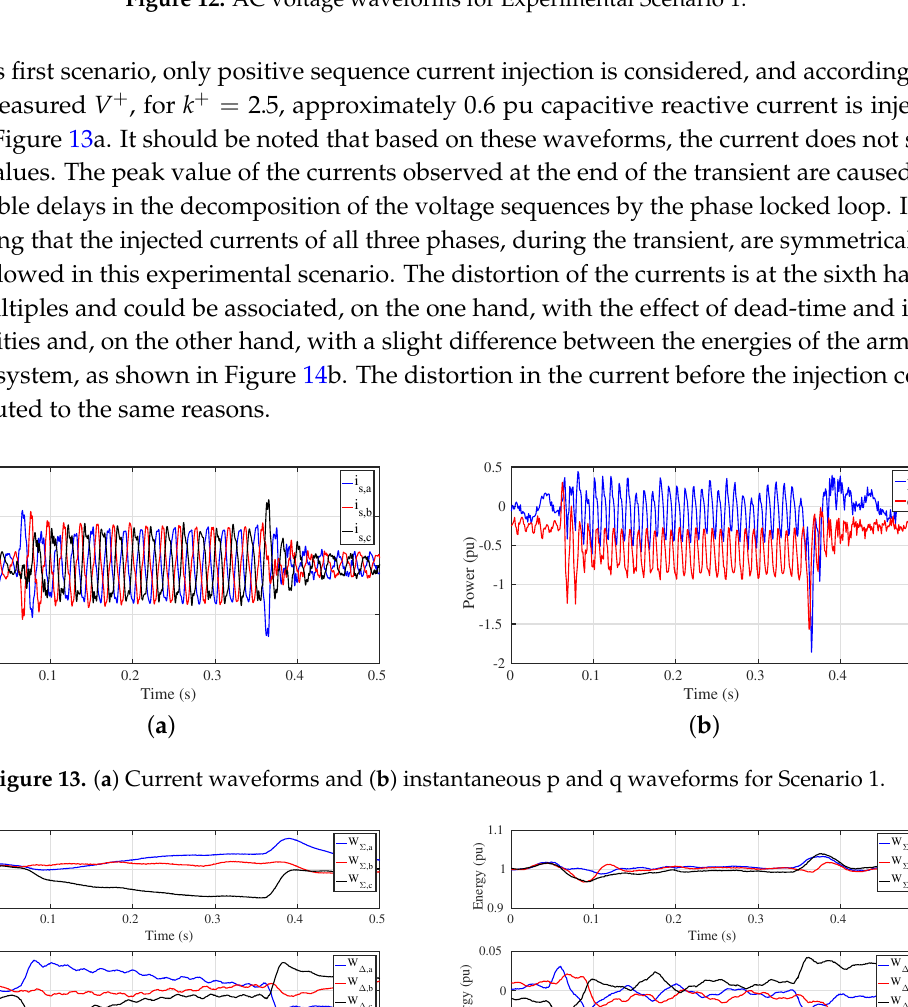
Figure 12. AC voltage waveforms for Experimental Scenario 1.